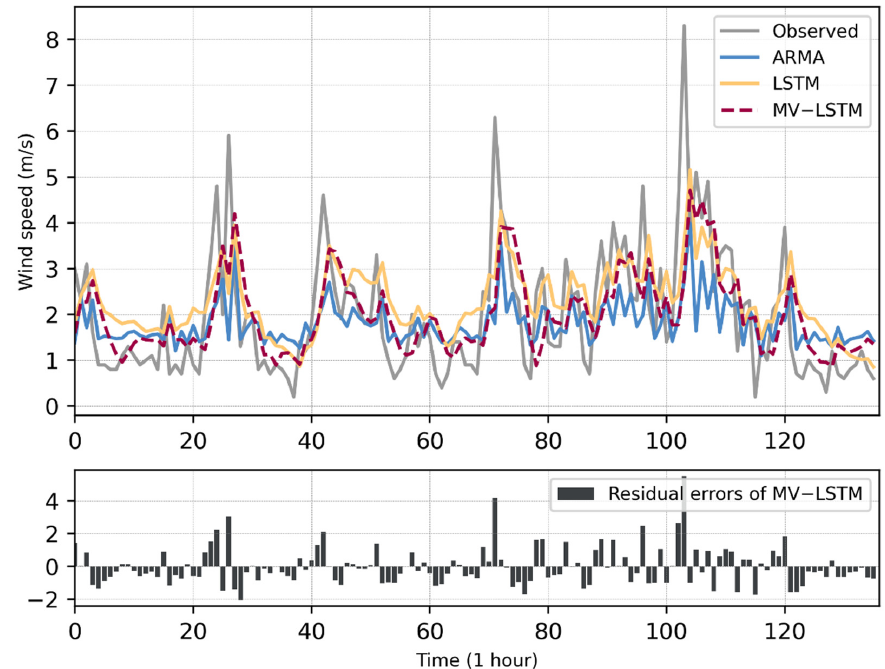
Figure 6. The wind speed forecasting results obtained by the different models on the dataset of Yanqing Station. In the top sub-figure, the x-axis is the wind speed value (unit: m/s), and the y-axis is the time of the data points (time interval: 1 h); in the bottom sub-figure, the x-axis is the residual errors of the MV-LSTM method (unit: m/s), and the y-axis is the same as it in the top sub-figure.